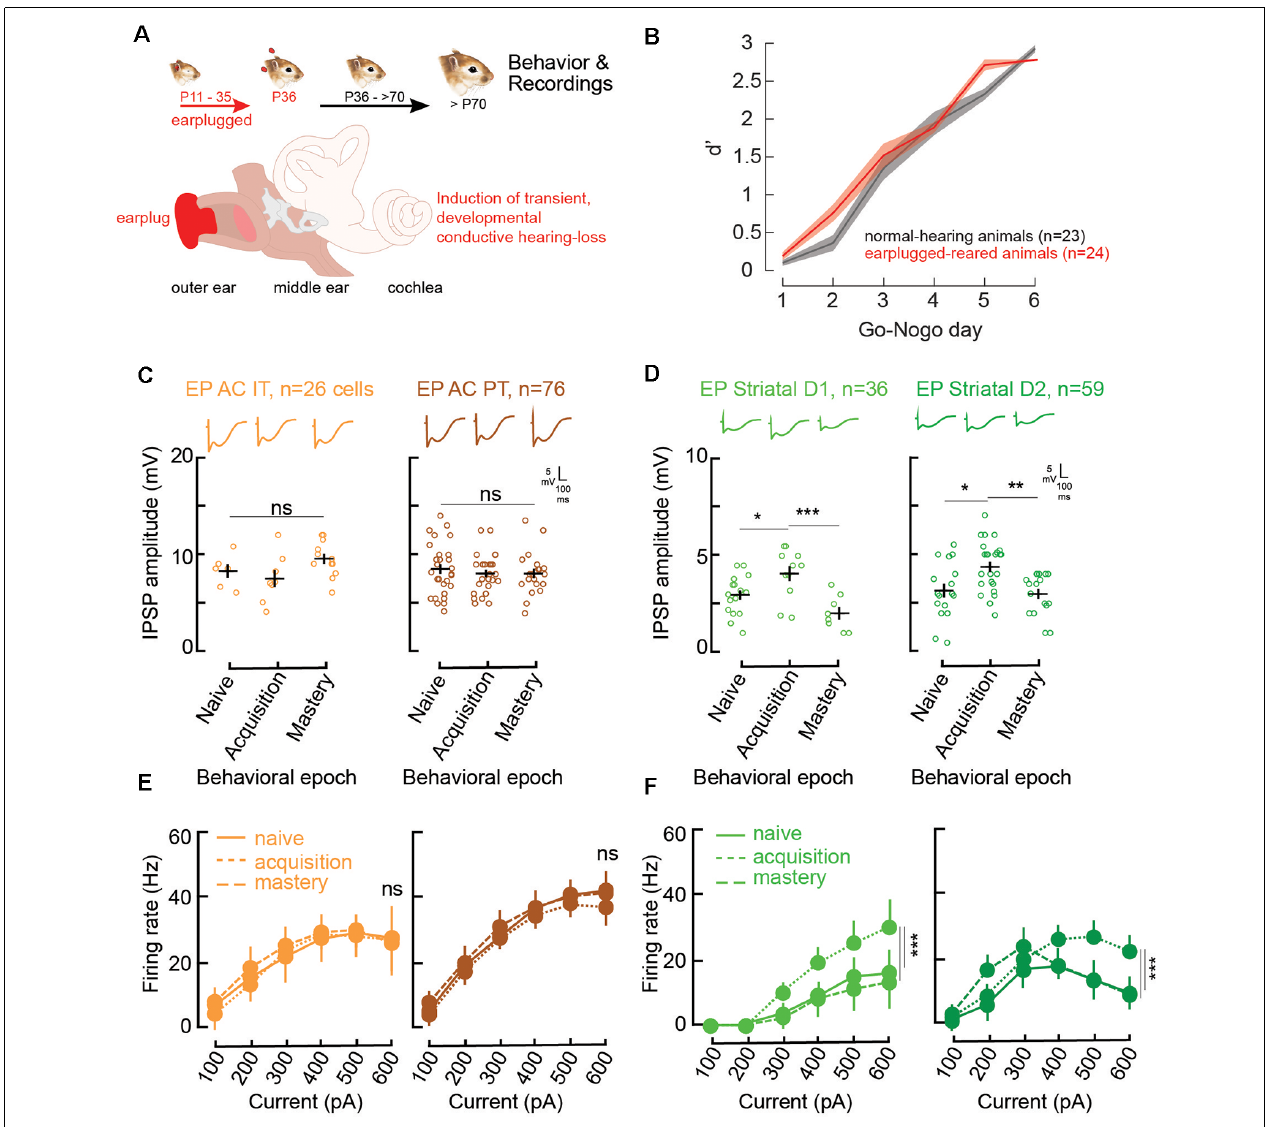
FIGURE 3 | Impaired corticostriatal circuit supports learning through increases in striatal inhibitory strengths and firing rates. (A) Illustration of the procedure for the induction of developmental auditory deprivation in gerbils. Animals were earplugged (EP) from P11 to P35. Behavioral testing and recordings began only from P70. (B) Mean ( ± SEM) d (cid:48) measures across Go-Nogo days for the control population (gray, n = 23) and the EP animals (red, n = 24). (C) Individual (open circles) and mean ( ± SEM, black lines) maximum evoked IPSP amplitudes of AC layer 5 IT and PT cells as a function of behavioral epochs for the EP animals. Representative traces are shown at the top. (D) Individual and mean ( ± SEM) IPSP amplitudes in striatal D1 and D2 cells as a function of behavioral epochs for the EP animals. (E) Input-output functions (firing rate patterns; mean ± SEM) for IT and PT cells as a function of behavioral epochs for the EP animals. (F) Input-output functions for striatal D1 and D2 cells as a function of behavioral epochs for the EP animals. Asterisks denote statistically significant differences at the following levels: * p < 0.05, ** p < 0.01, *** p < 0.001, and ns = not